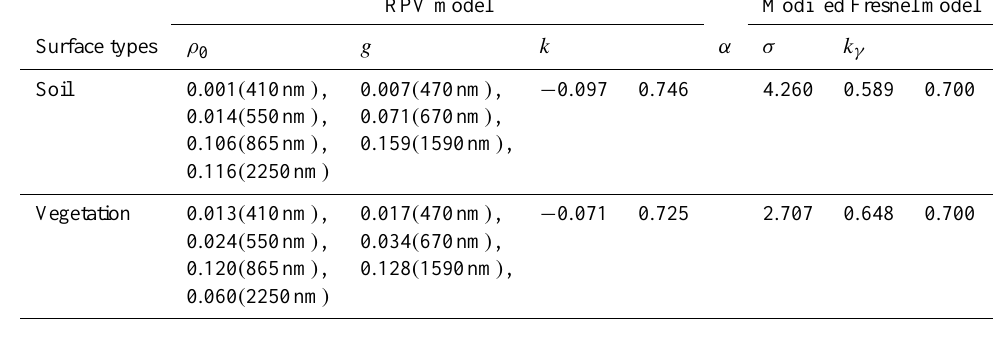
Table 4. Parameters of RPV model and the modified Fresnel model used in synthetic retrieval.